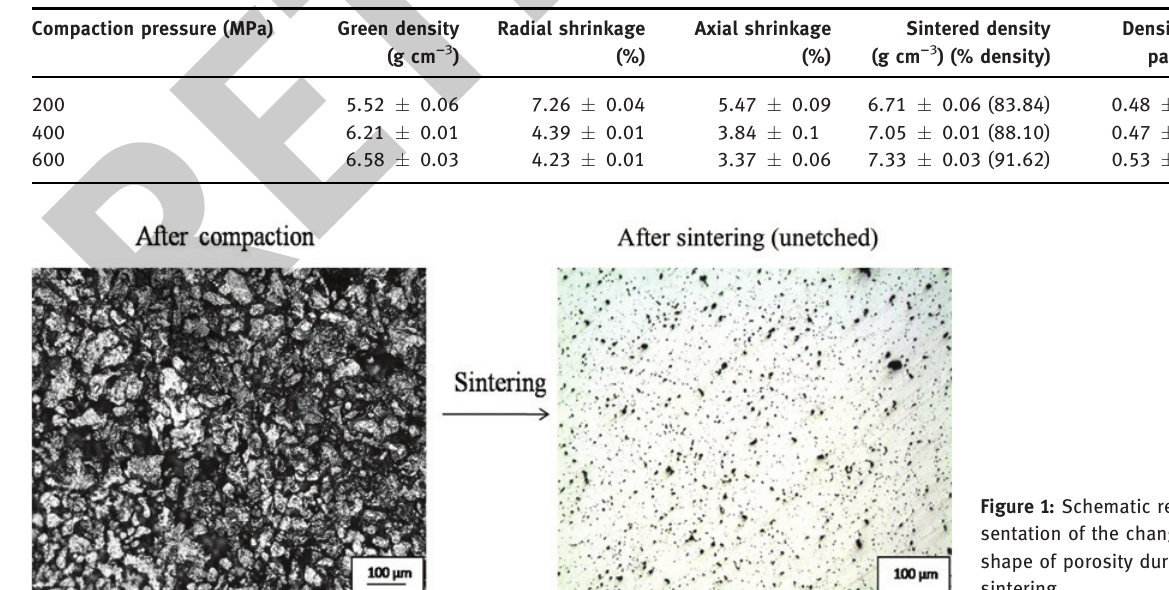
Figure 1: Schematic repre- sentation of the change in shape of porosity during